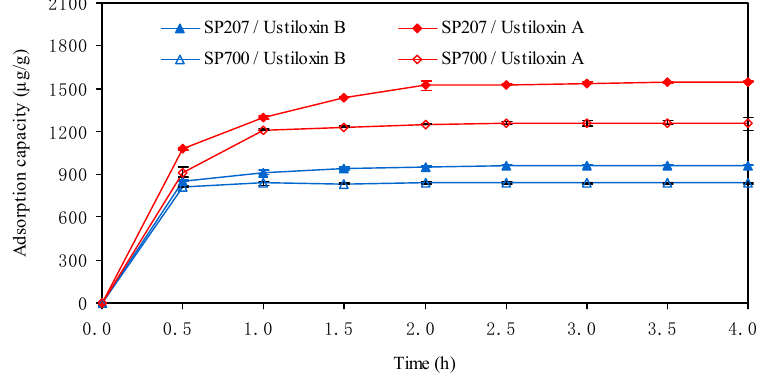
Figure 1. Static adsorption kinetics curves of resins SP207 and SP700 for ustiloxins A and B.